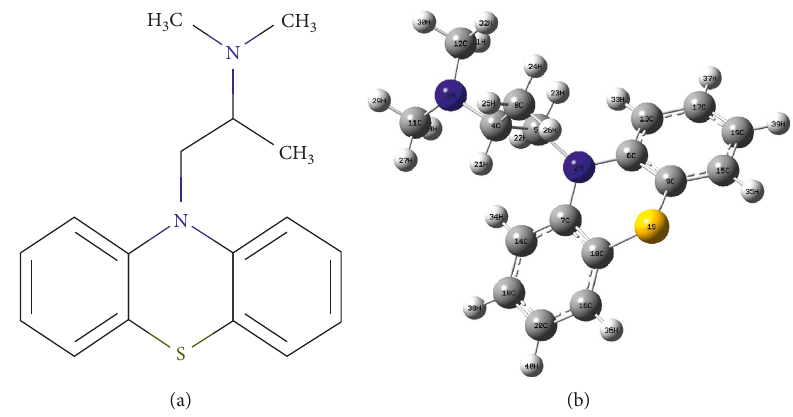
Figure 3: Molecular structure of promethazine.